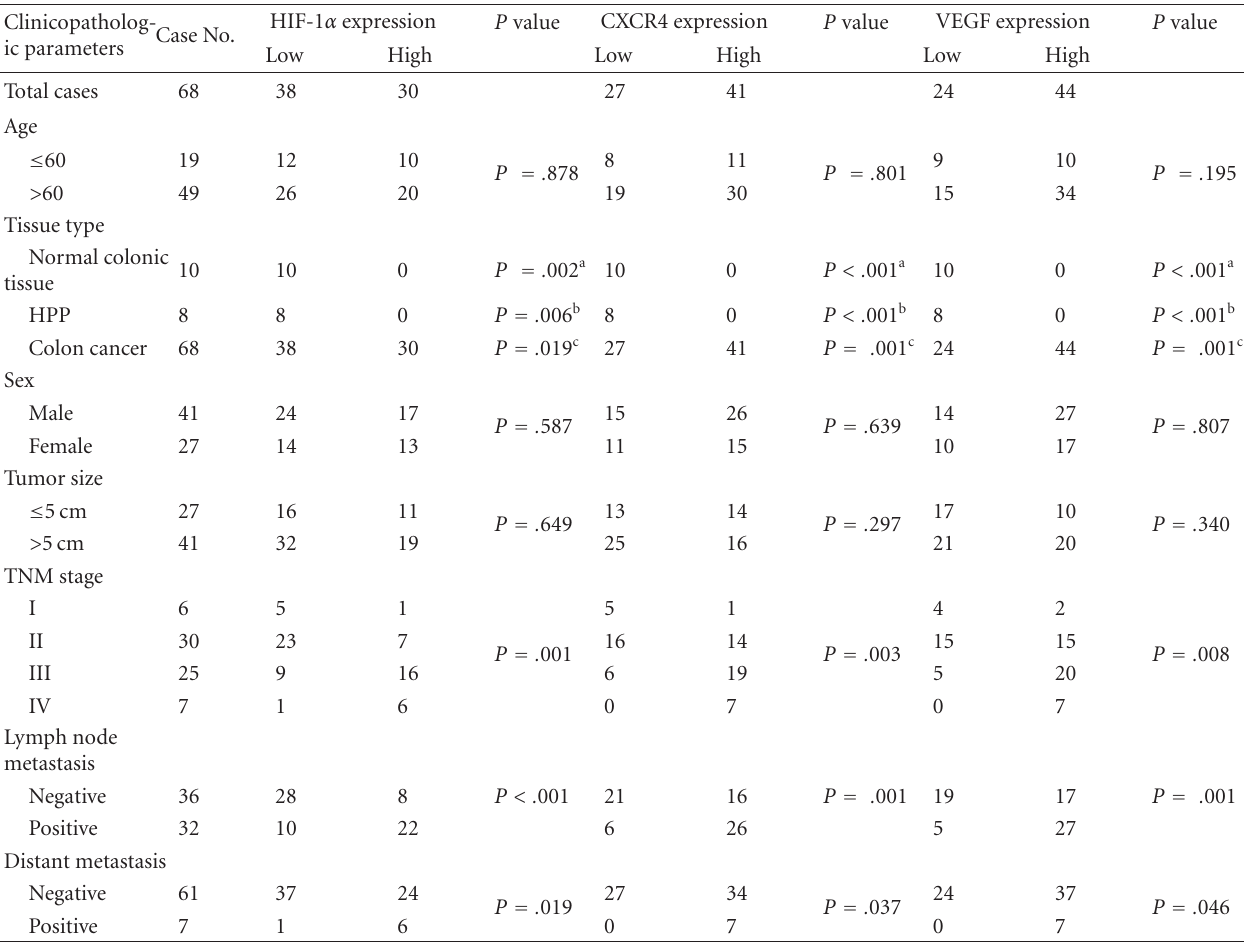
Table 1: Correlation of HIF-1 α , CXCR4, and VEGF expression with clinicopathologic features in colon cancer. Sections were subjected to routine depara ffi nization and rehydration. Antigen retrieval was achieved by microwaving in citrate bu ff er for 10min. The endogenous peroxidase activity was inhibited by incubation with 3% hydrogen peroxide. The specimens were reacted overnight with anti-HIF-1 α antibodies, anti-CXCR4 antibodies, and anti-VEGF antibodies, then were incubated with rat anti-mouse-IgG2b-horseradish peroxidase. The sections were then counterstained with hematoxylin and mounted (see Section 2). Staining intensity and percentage of positive tumor cells were assessed. Multiplication of the intensity and the percentage scores gave rise to the final staining score: 0 (negative), + (1–4), ++ (5–8), and +++ (9–12). For statistical analysis, tumors having staining scores of 0 or + were designated the low expression group, and tumors with scores of ++ or +++ the high expression group. The correlation between clinicopathologic parameters and HIF-1 α , CXCR4, and VEGF expression were analyzed by Chi-squared test or Fisher’s exact test. Abbreviations: HIF-1 α : Hypoxia-inducible factor-1; CXCR4: CXC chemokine receptor 4; VEGF: vascular endothelial growth factor; HPP: hyperplastic polyps; TNM: